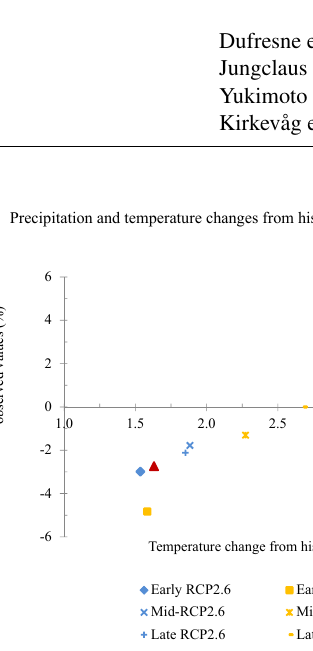
Figure 3. Average annual precipitation and temperature changes for the three RCP scenarios in early, mid and late century compared to historical-observed (1991–2010)